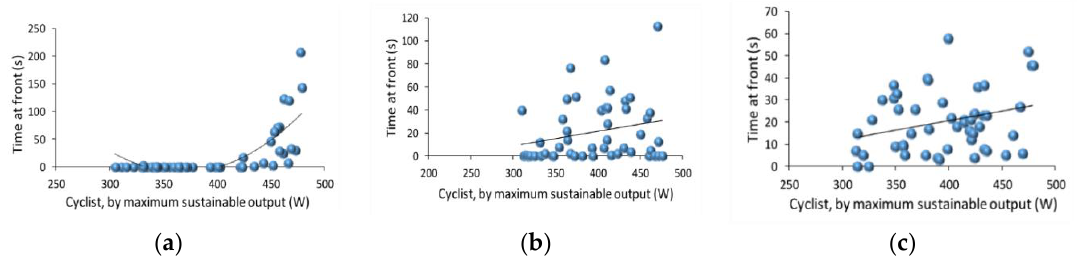
Figure 1. ( a ) Simulated cyclists travel at high speeds relative to their maximal capacities. The peloton self-organizes so that strongest simulated cyclists tend to spend the most time in highest cost front positions ( R = 0.7547); ( b ) Simulated cyclists travel at medium speeds relative to their maximal capacities. Here there is no discernable preference for cyclists of any strength to dominate the front position. While they do not all share the highest cost position equally, sharing is more randomly distributed ( R = 0.2825); ( c ) Simulated cyclists travel at low speeds relative to their maximal capacities. Like cyclists traveling at mid-speeds, there is no discernable preference for cyclists of any strength to dominate the front position ( R = 0.2546). Image adapted from [44] (Figures 4–6).